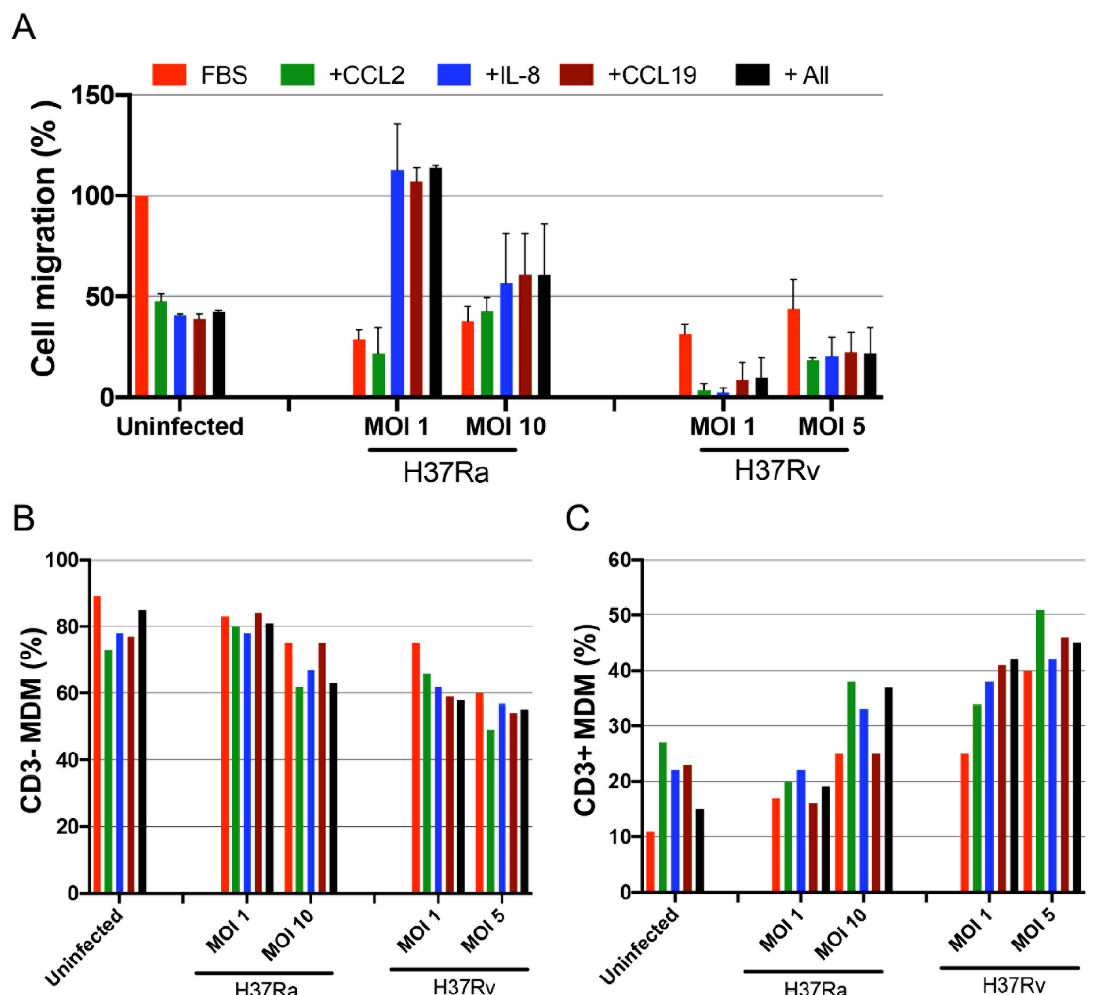
Figure 6. The migration ability of CD3 + monocyte-derived macrophages (MDMs) is modulated depending on Mycobacterium tuberculosis (Mtb) virulence. MDMs infected with H37Ra (MOI = 1 and 10) or H37Rv (MOI = 1 and 5) Mtb strains were recovered 24 h post-infection to evaluate their migration ability in response to CCL2, IL-8, and CCL19 chemoattractants using a quantitative fluorometric assay. A 100 µ L suspension of infected MDMs (4 × 10 5 ) was added to each well. ( A ) Cell migration percentage of Mtb-infected MDMs from three donors was calculated; uninfected MDMs in the presence of the attractant 10% fetal bovine serum were used as a reference (100%). The frequencies of transmigrated cells analyzed by flow cytometry ( B ), percentage of transmigrated CD3 − MDMs, and ( C ) CD3 + MDM subpopulations are shown. Bar graphs show median values and interquartile ranges (IQRs, 10–90) from three independent